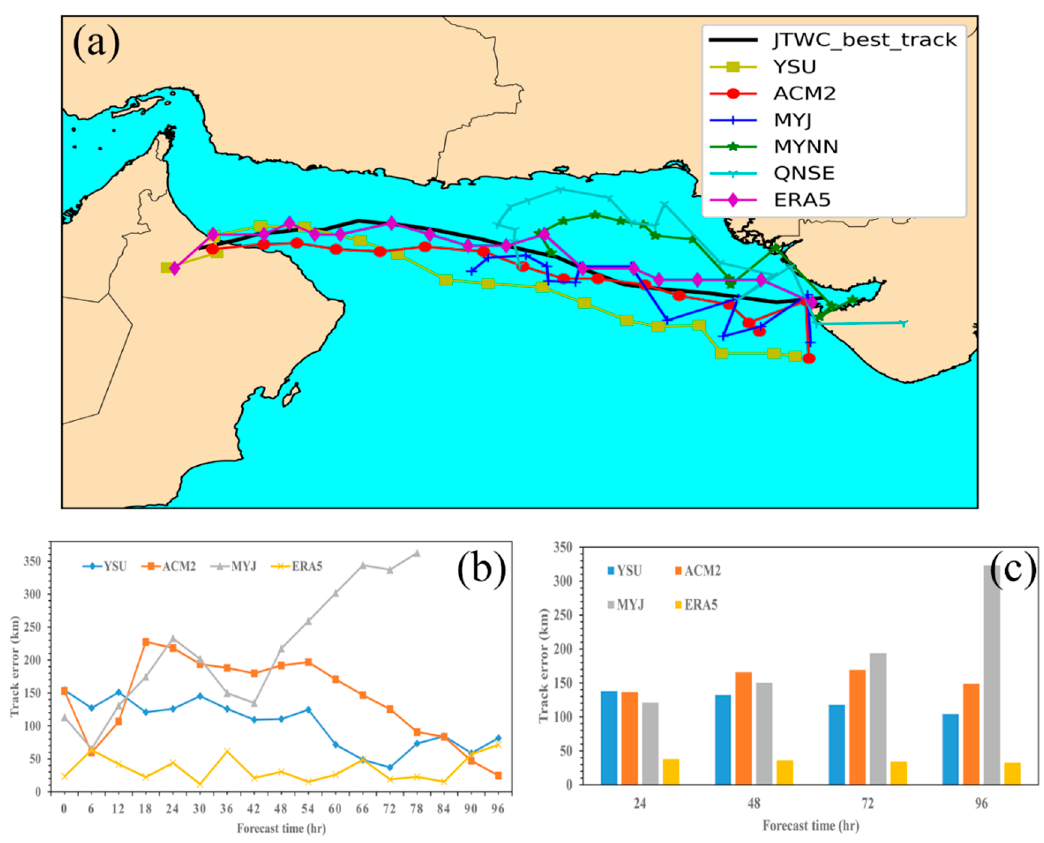
Figure 4. Predicted tracks of Cyclone Shaheen with different PBL schemes along with JTWC best-fit track of Cyclone Shaheen, ( a ) track, ( b , c ) temporal variation in track error. The simulated cyclone intensity (hPa) and strength (m/s) by WRF using five parame- terizations for PBL and ERA5 reanalysis data were compared against JTWC data in Figure 5. and strength variations by all schemes were in a good agreement with JTWC, except